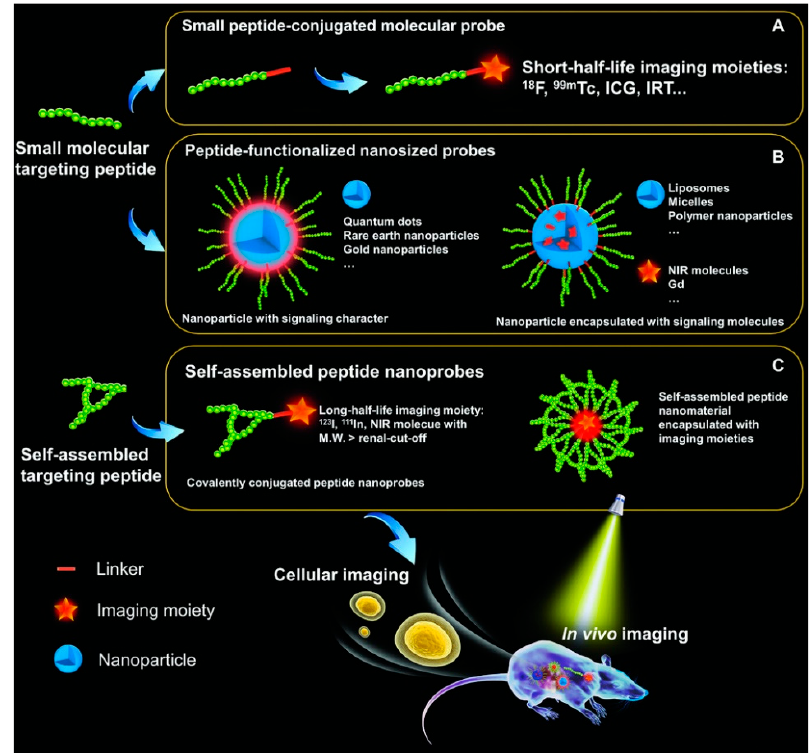
Figure 10. General scheme of targeting peptide-based probes for molecular imaging. ( A ) General conjuga-tion of peptide with a molecular probe. ( B ) Functionalization of nanoparticles with conju- gated peptides. ( C ) Self-assembled peptide nanoprobes with additional targeting. Reprinted with per-mission from Ref. [158].